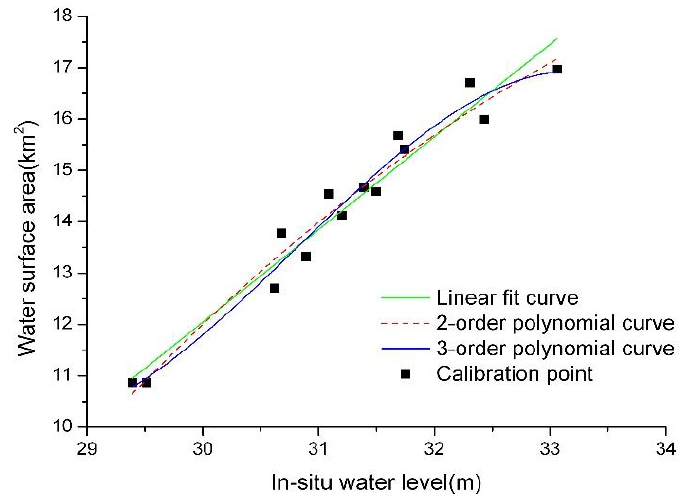
Figure 3. Correlation analysis for the LRC method between the water surface area and the in situ water level. Table 1. Fitting equations of the surface areas and in situ water levels in 2011 and